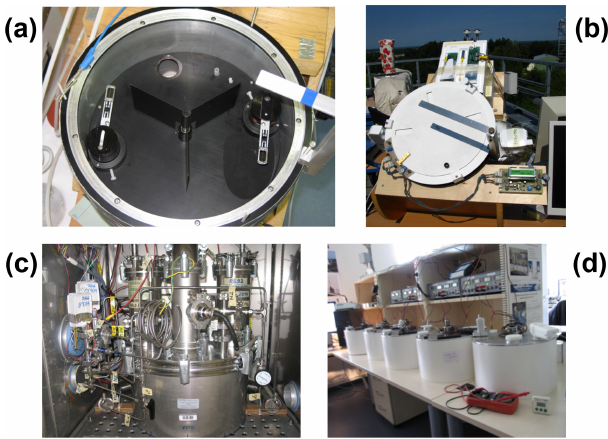
Figure 3. Overview of the experimental equipment used to char- acterize the measurement errors and uncertainties of the RS92 and RS41 sensors. (a) Radiation test chamber (top view). (b) Radiation test chamber in operation, oriented perpendicular to the Sun (light source). Visible on top of the quartz plate is the shutter, with three opening slits, allowing for simultaneous testing of three radioson- des. (c) Climate chamber that is used to test the performance of ra- diosondes under various temperature, pressure, and humidity con- ditions. In the configuration shown here, the response time lag of the humidity sensor is investigated. (d) Standard humidity cham- bers that contain reference saline solutions that generate RH envi- ronments between 0 and